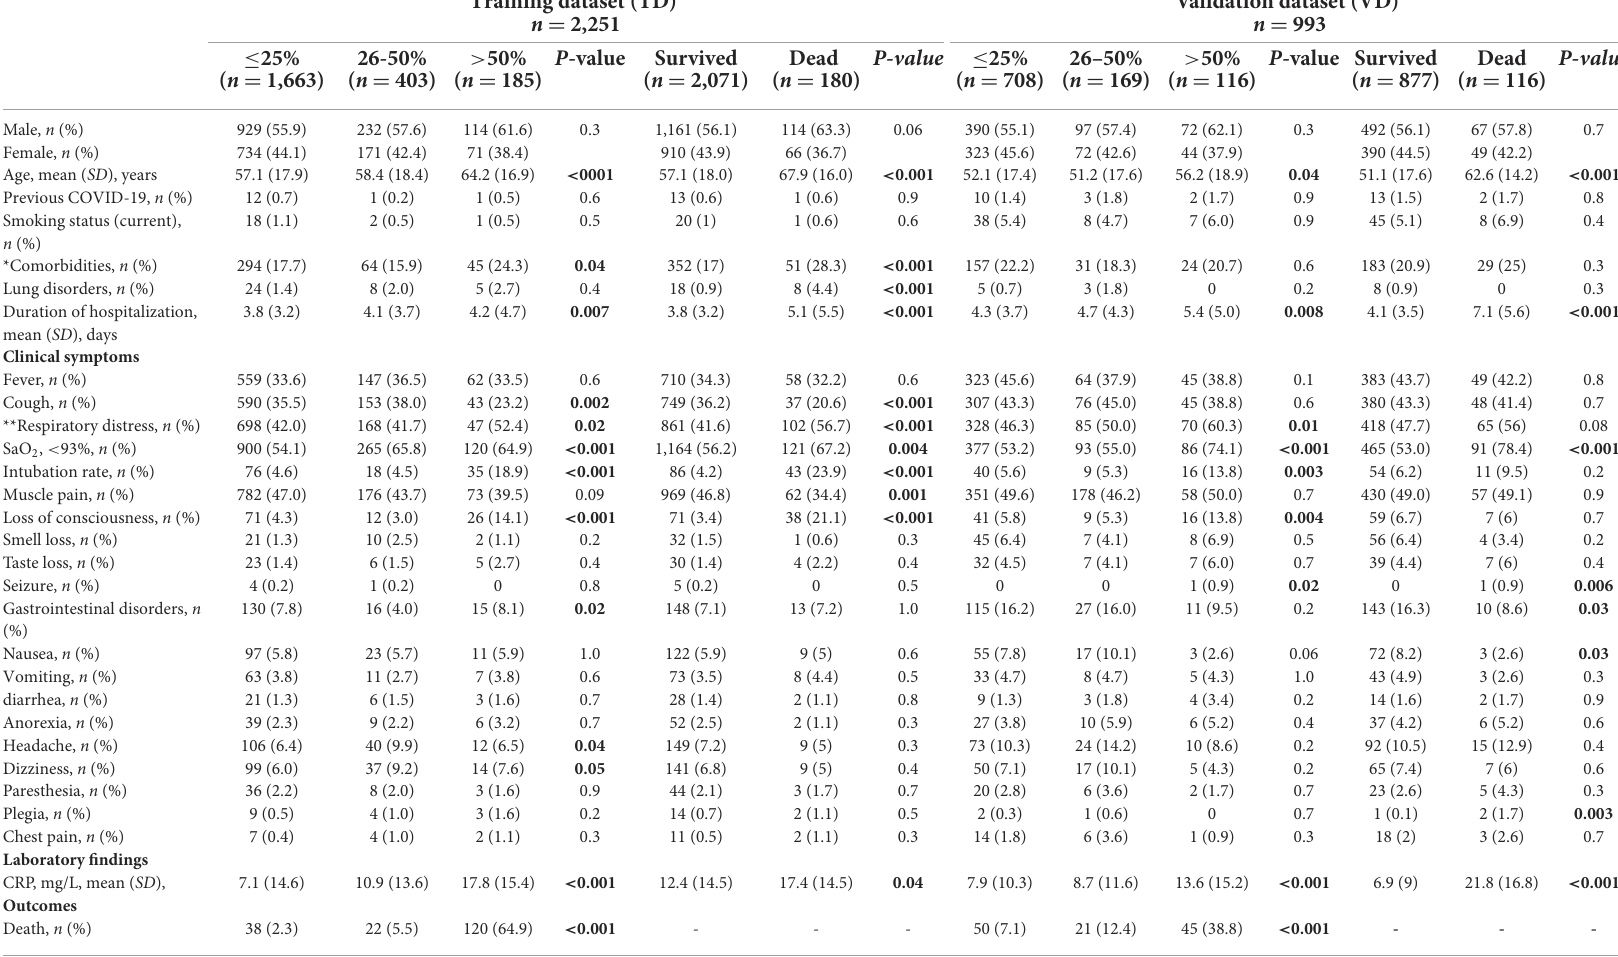
TABLE 1 Baseline characteristics of the patients with COVID-19 according to the extent of lung involvement and in-hospital death. Training dataset